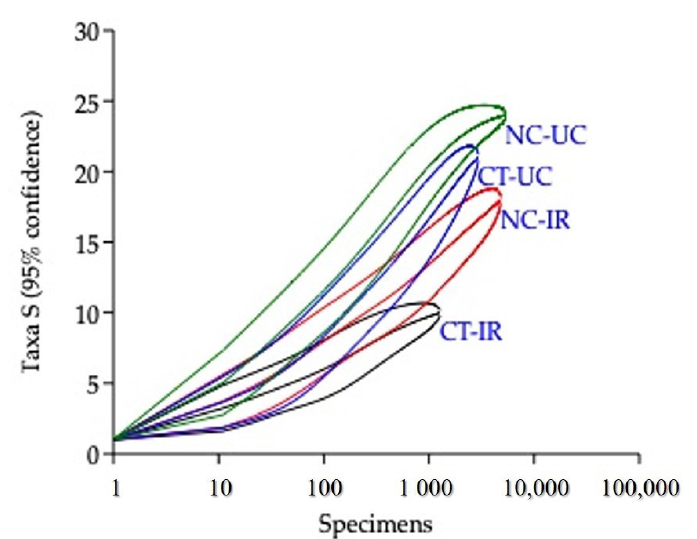
Figure 5. Assemblage differences of edaphic arthropods communities in 0–10 cm of the soil layers in both environment conditions: management (conservative tillage or natural cover) and position (under olive canopy or inter-row). The extrapolated rarefaction method provides a 95% confidence interval of the expected taxa richness based on the bootstrap method. The coordinates represent the sampled number of individuals and overall population size for each taxa group, respectively.